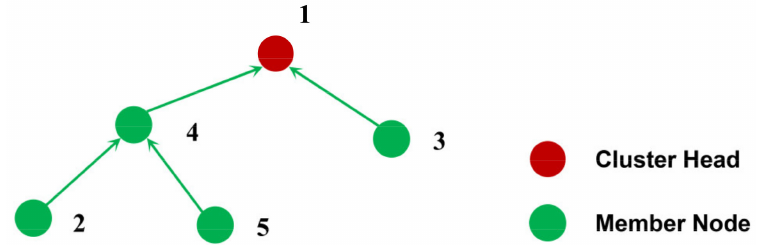
Figure 6. A simple